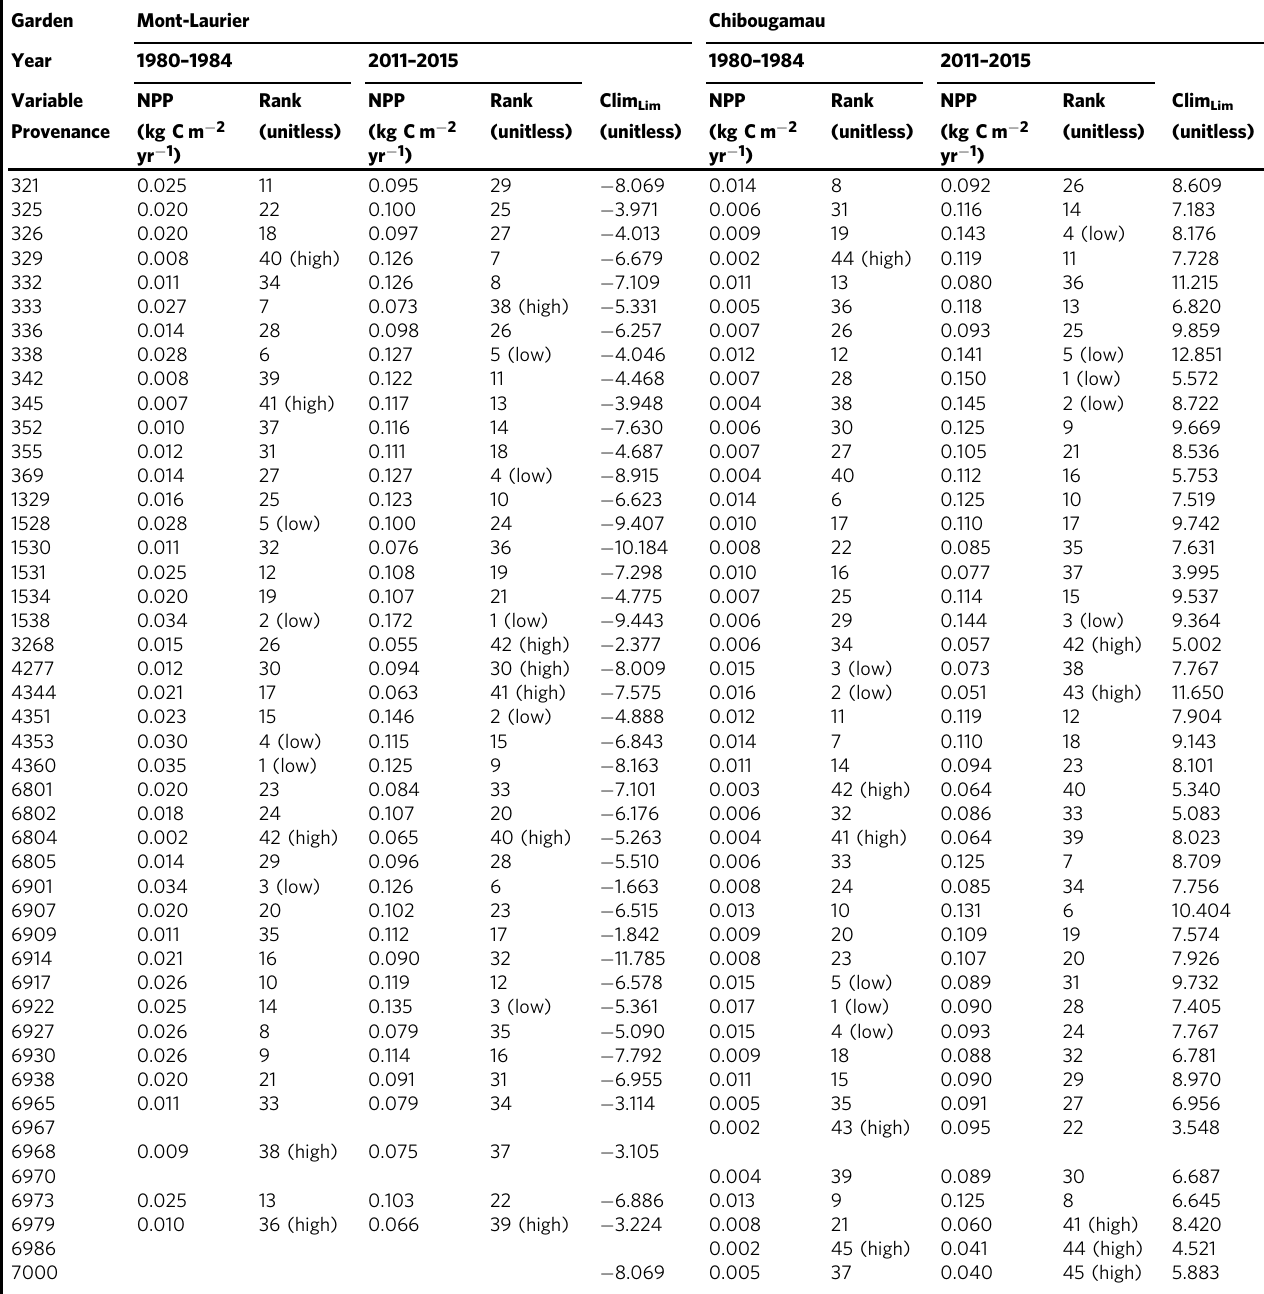
Table 1 Annual net primary productivity (NPP) by provenance and common garden, averaged over 1980 – 1984 and 2011 – 2015.